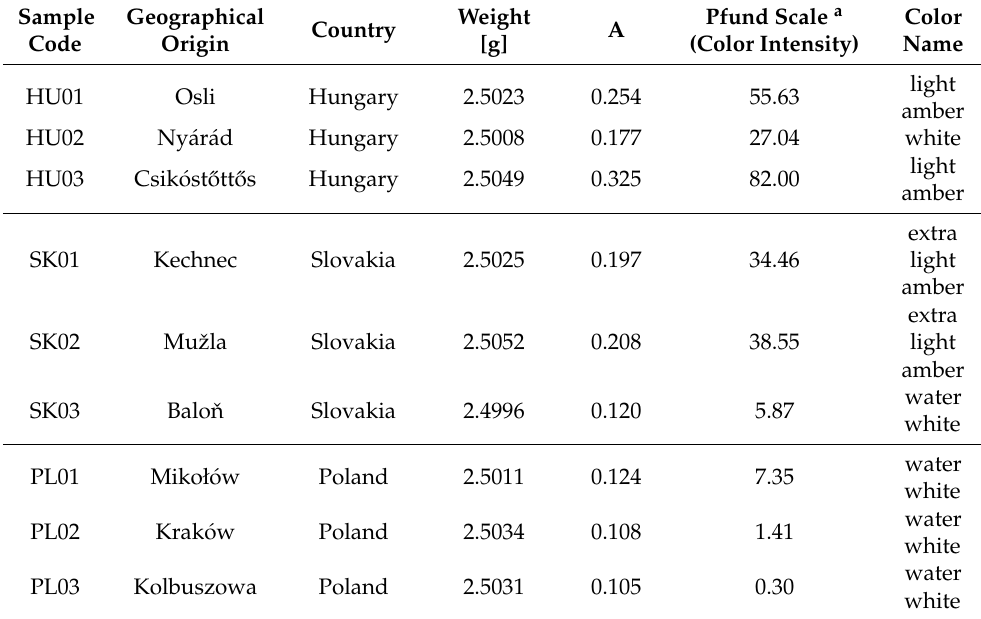
Table 2. Color intensity of Hungarian-, Slovak-, and Polish-origin goldenrod honey. Sample